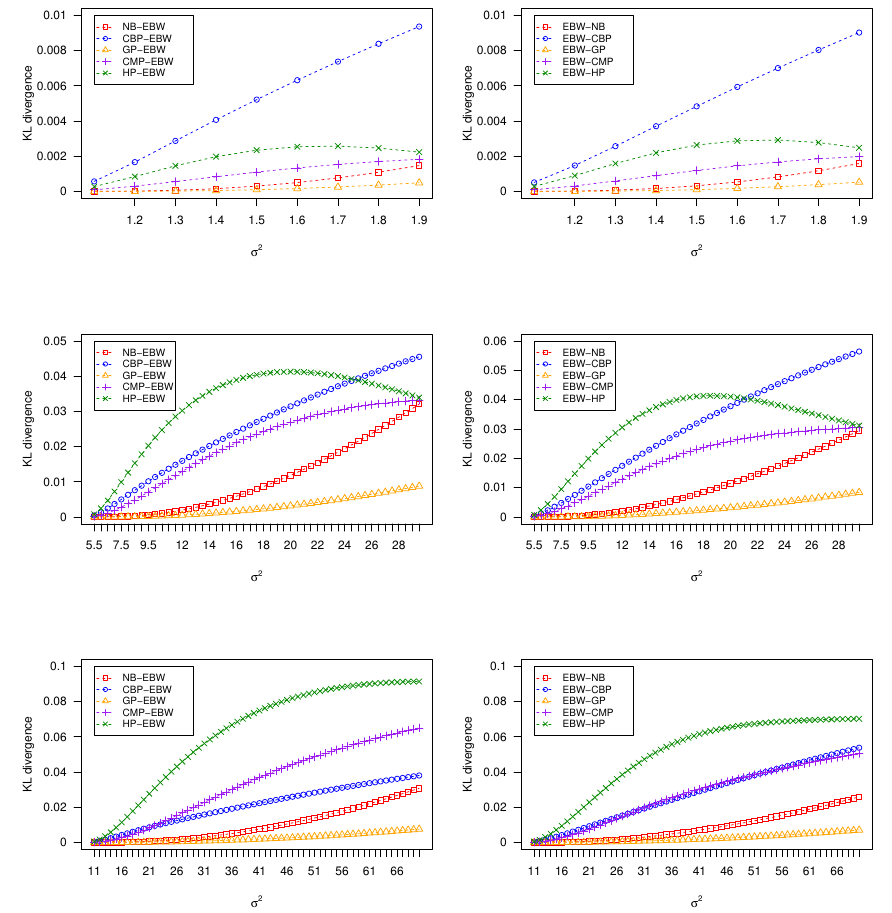
Figure 3. Kullback Leibler divergence between the negative binomial ( NB ), Complex Biparametric Pearson ( CBP ), Generalized Poisson ( GP ), COM-Poisson ( CMP ), Hyper-Poisson ( HP ) and EBW distributions (and vice versa) in an overdispersed scenario. Rows 1–3 have µ = 1, µ = 5 and µ = 10,